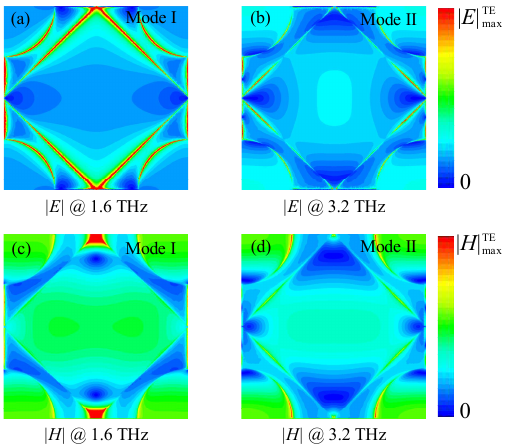
Figure 4. ( a – d ) The electric and magnetic field distributions at the resonance frequencies of 1.6 THz and 3.2 THz on the hybrid-patterned graphene layer of the proposed absorber, respectively.